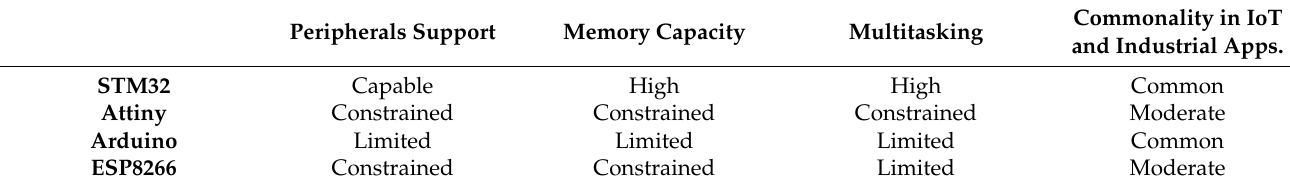
Table 1. Comparison between common used microcontrollers